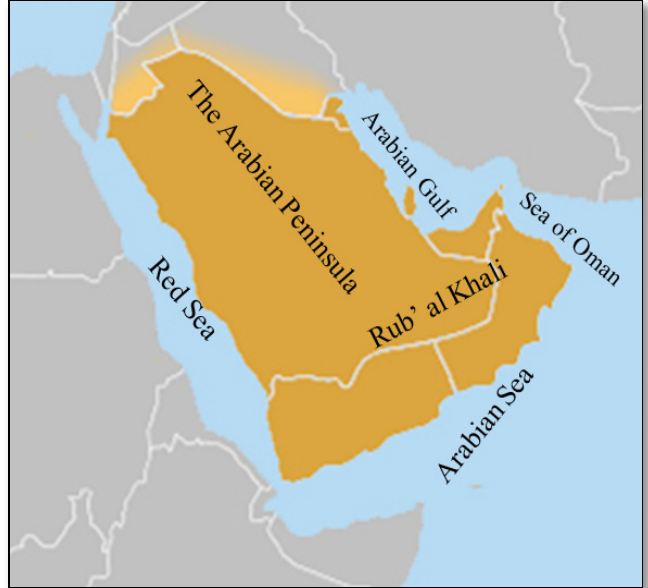
Figure 1. Map of the Arabian Peninsula.